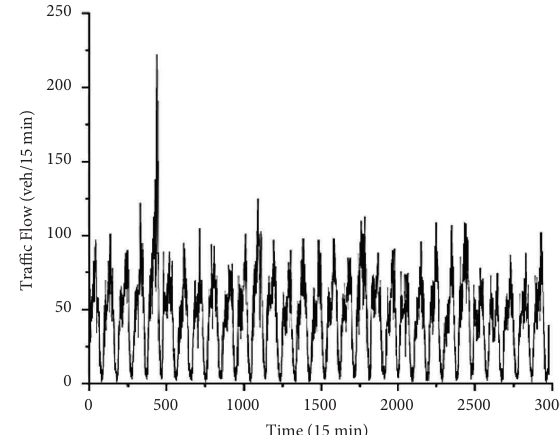
Figure 2: Highway toll 15minutes interval trafc fow.